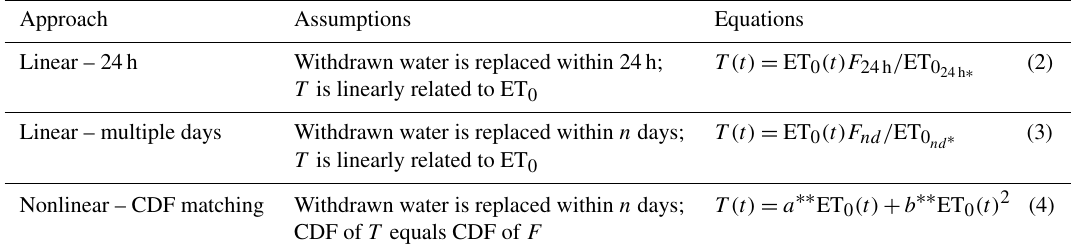
Table 1. The three tested approaches to estimate transpiration ( T ) using Penman–Monteith-derived ET 0 estimates and sap flow measure- ments.